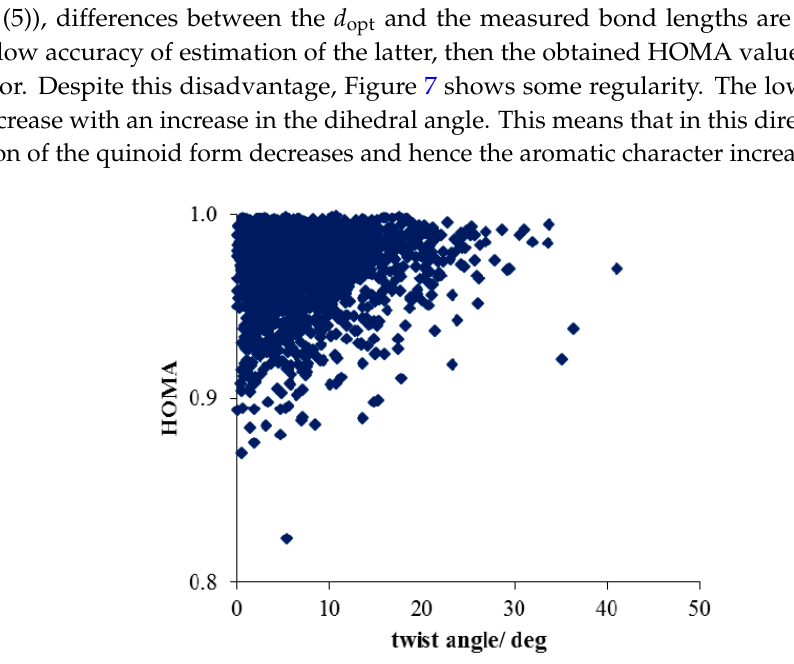
Figure 7. Dependence of HOMA on angle between planes for NO 2 and carbon atoms of the benzene ring for para -substituted nitrobenzene derivatives.